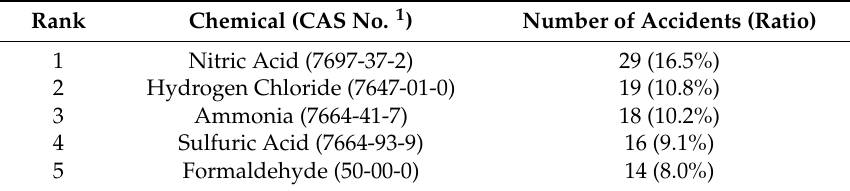
Table 1. The number of accidents by “chemicals requiring preparation for accidents” during 1 January 2015–31 December 2017.